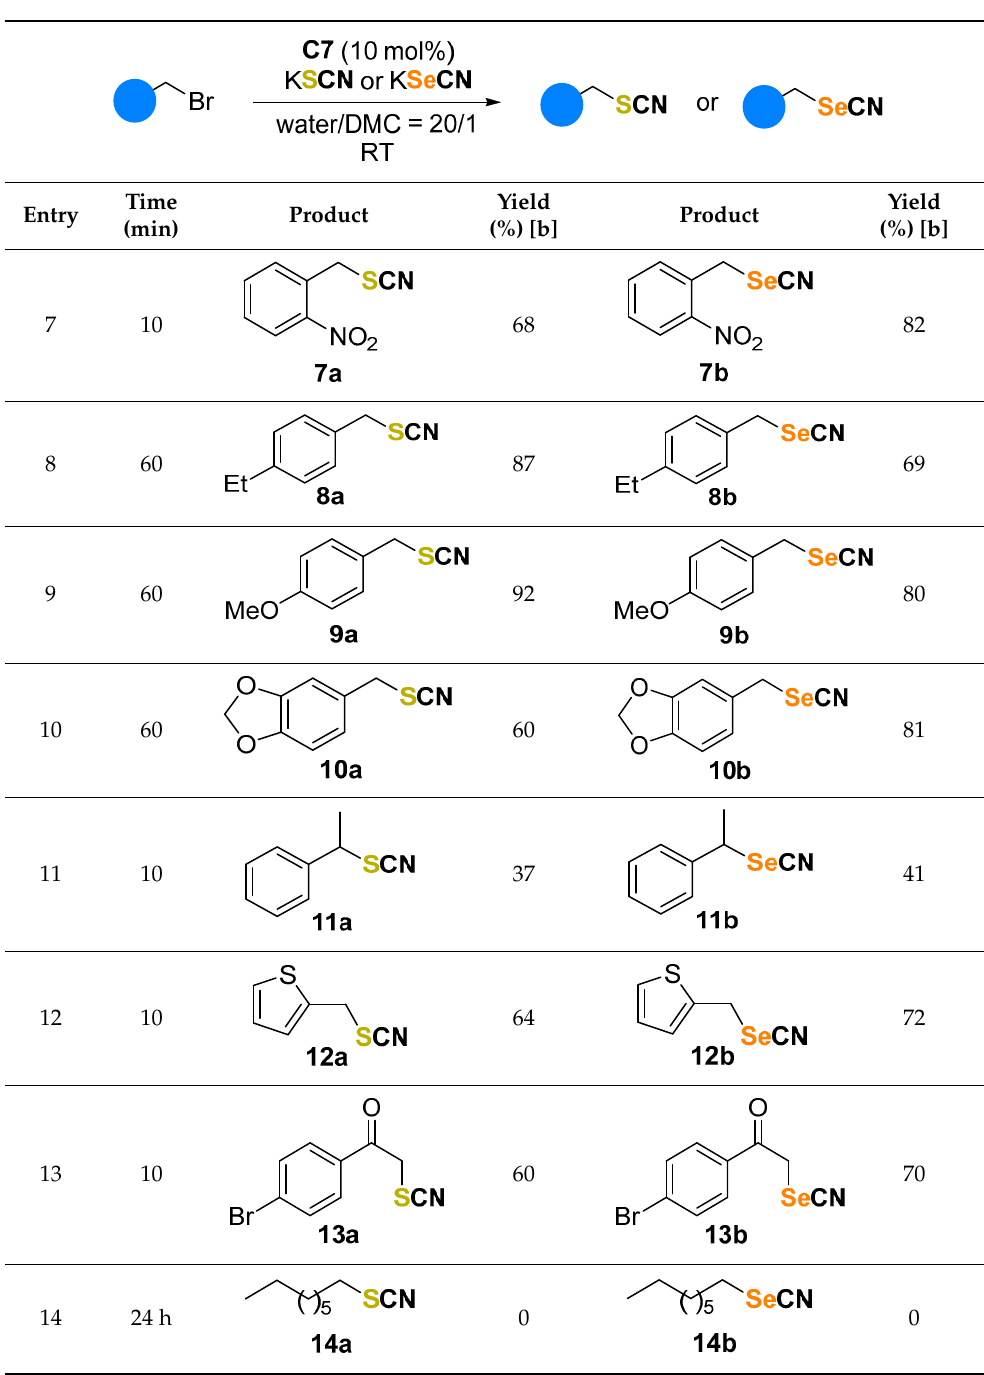
Table 3. Cont. Table 3. Substrate scope for the preparation of thio- and selenocyanates catalyzed by C7 .